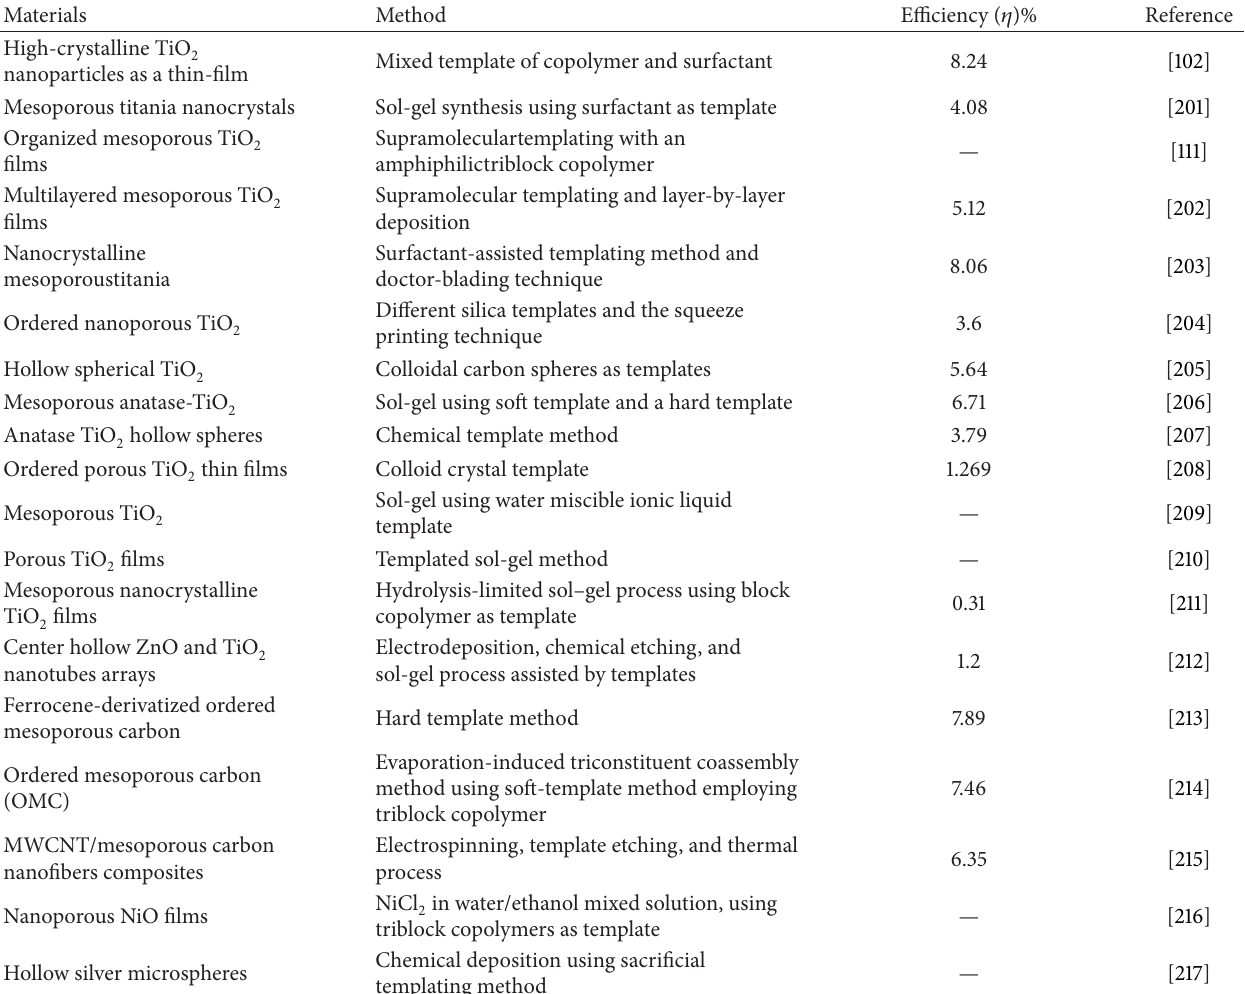
Table 6: Some research work on DSSC that used template